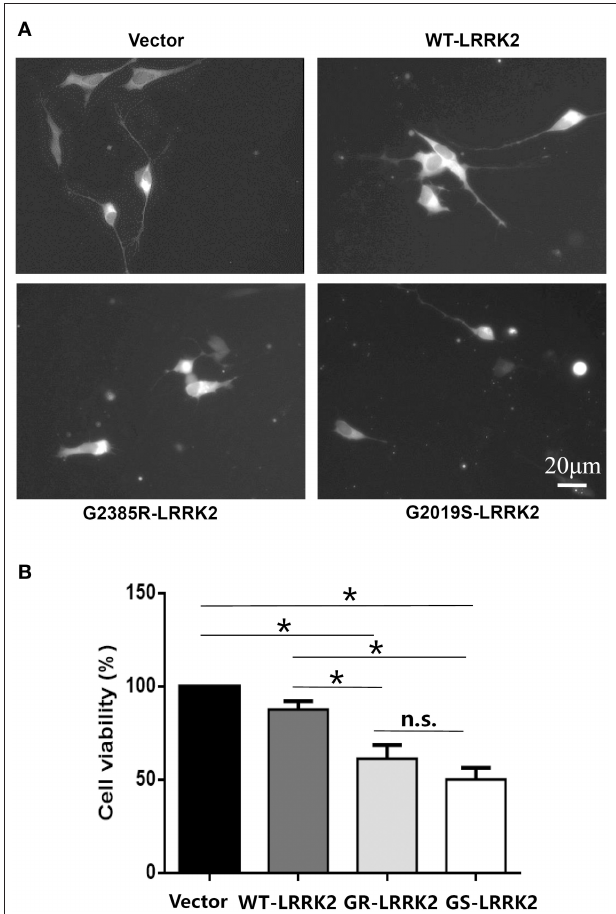
FIGURE 1 | G2385R(GR)-LRRK2 induced neurodegeneration in SH-SY5Y cells. SH-SY5Y cells were co-transfected with GFP and vector or various LRRK2 constructs at 1:10 ration for 48h. (A) Representative fluorescent images of cells in each group. (B) Cells viability. * p < 0.05, statistical significance between groups as indicated. NS, no significance; GS,